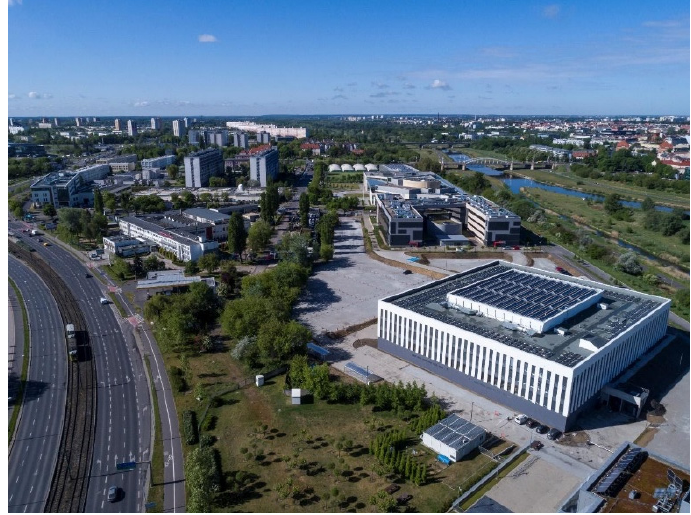
Figure 3. Location of the nZEB building (research object) on the Poznan University of Technology campus.